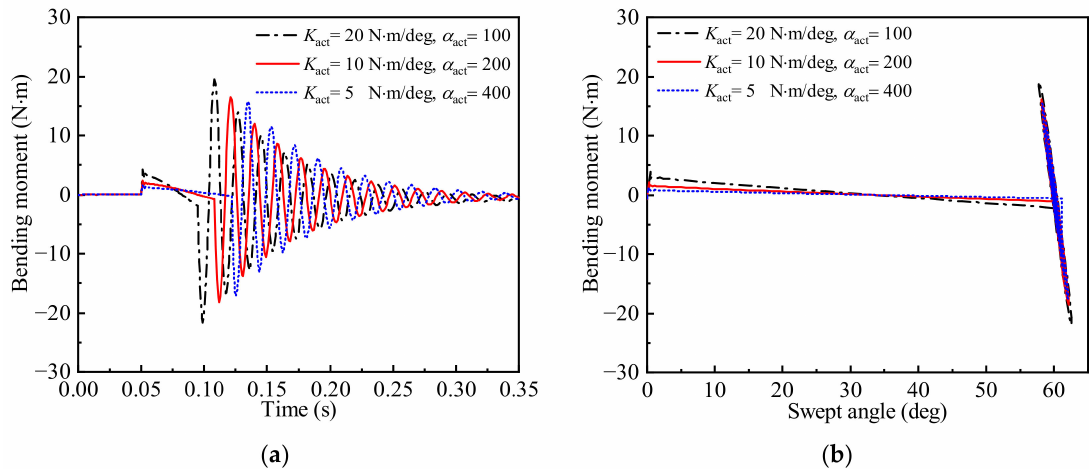
Figure 20. Transient responses of the wing root bending moment. ( a ) Bending moment vs. time. ( b ) Bending moment vs. sweep